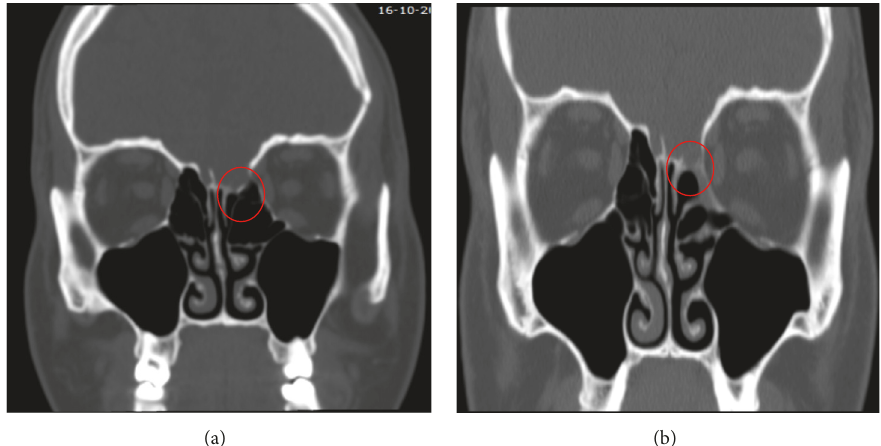
Figure 5: Case 2. (a) Preoperative CT scan showing a CSF leak in the left cribriform plate. (b) Seven-month postoperative CT showing a less dense bony closure of the surgical